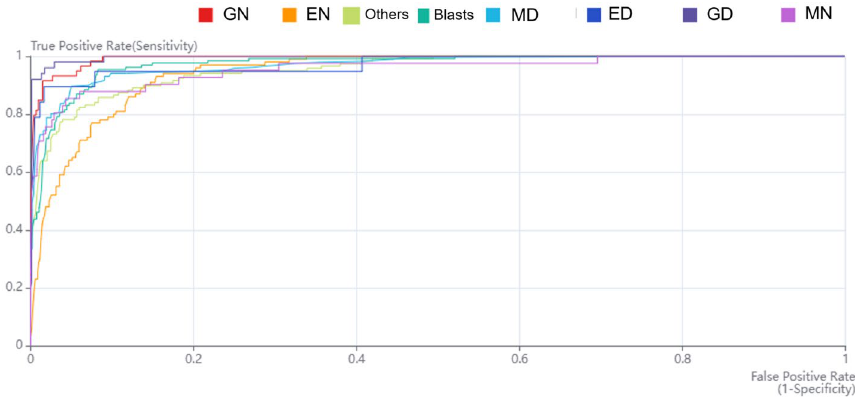
Figure 1. Receiver operating characteristic curves for classification of normal and abnormal cells in patients with myelodysplastic. Eight types of cells: normal erythrocytes (EN), normal granulocytes (GN), normal